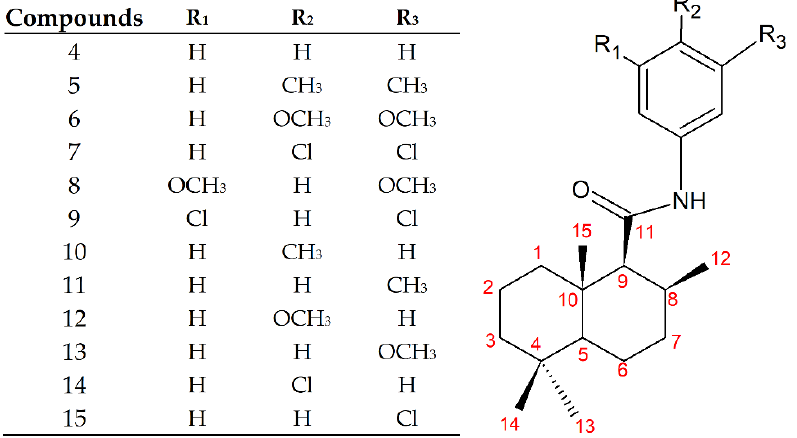
Figure 2. Synthesized compounds.